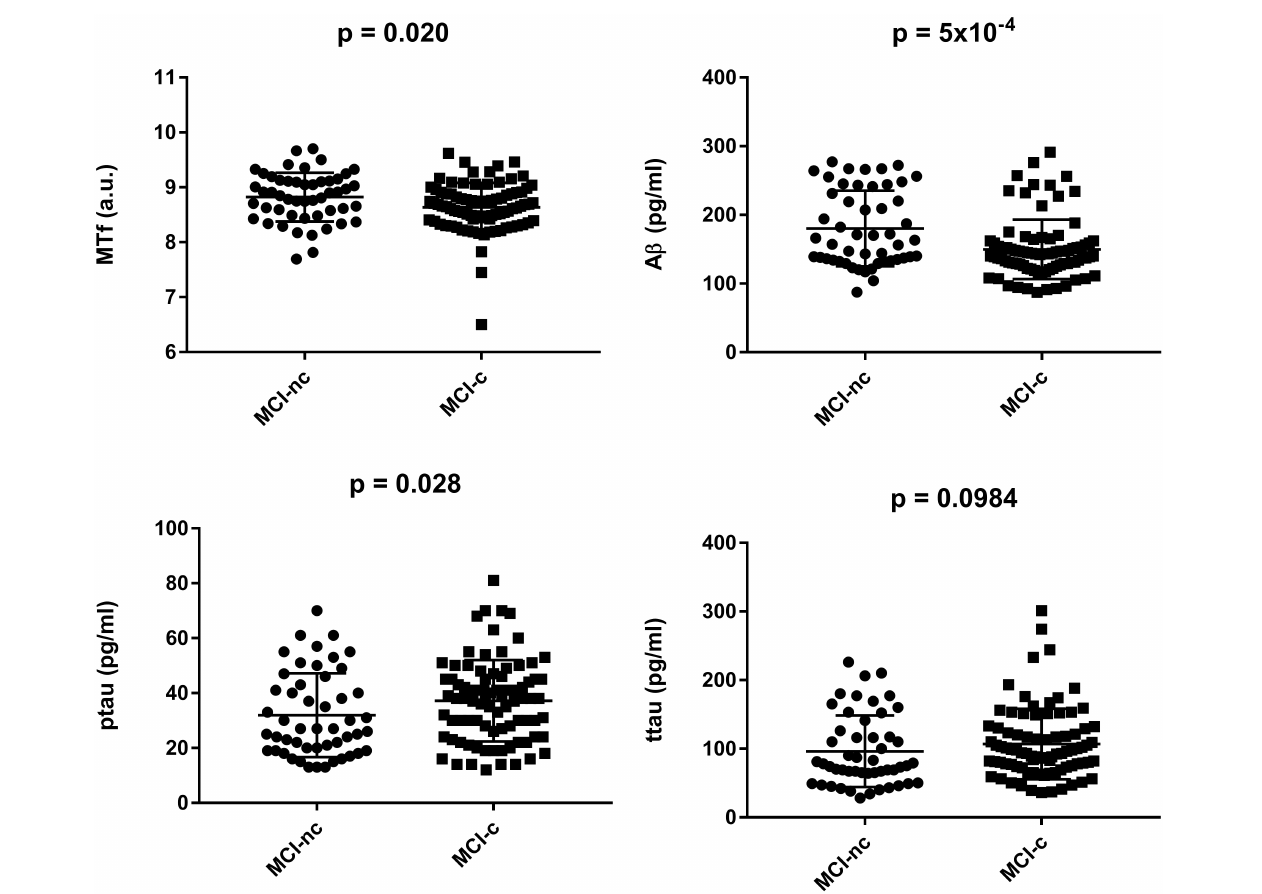
FIGURE 1 | Baseline characteristics of mild cognitive impaired subjects stratified by conversion to Alzheimer’s Disease. Data are represented as mean ± standard deviation. The student’s T -test was used to test for differences in CSF melanotransferrin (MTf), A β , phosphorylated tau (ptau), and total tau (ttau) between non-converters (MCI-nc) and converters (MCI-c) with p < 0.05 being considered